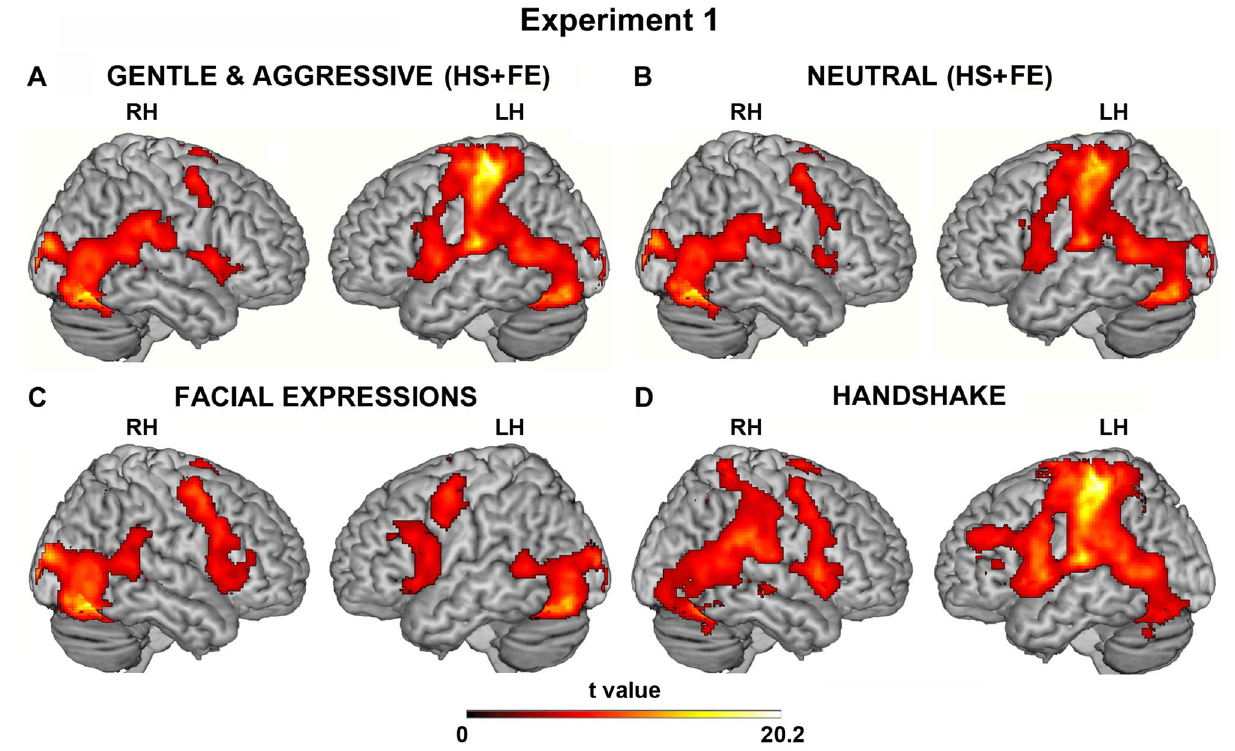
Figure 3. Brain activations resulting from the three different situations (handshake and facial expression, HS + FE; facial expression, FE; handshake, HS). Activations obtained in the first situation (HS + FE) during the vitality forms (aggressive and gentle) ( A ) and neutral ( B ) (control) conditions vs. baseline. Activations obtained in the second (FE) ( C ) and third situations (HS) ( D ) vs. baseline. These activations are rendered using a standard Montreal Neurological Institute brain template (P FWE < 0.05 voxel level). LH, left hemisphere; RH, right